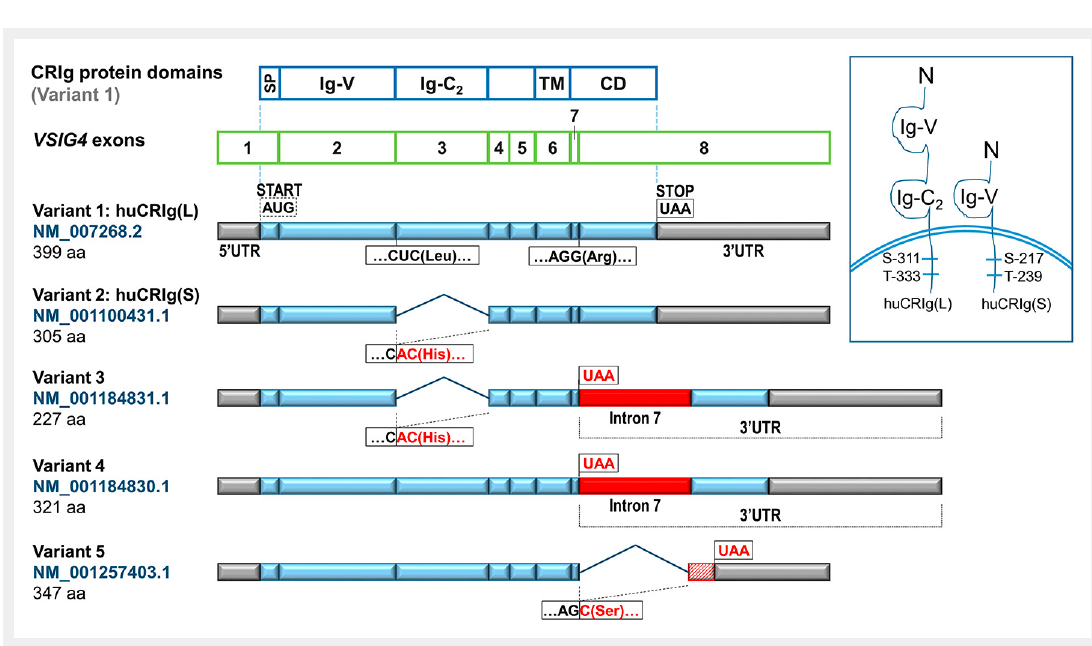
Schematic representation of the CRIg protein domains aligned with the five VSIG4 splice variant transcript structures. The transcripts structures are derived from the NCBI Reference Sequence Database (RefSeq) using the following mRNA accession numbers: NM_007268.2, NM_001100431.1, NM_001184831.1, NM_001184830.1, and NM_001257403.1, as noted in the figure. The structure of the longest CRIg isoform (variant 1, huCRIg(L)) is used as the reference, with the protein domains denoted as: SP, signal peptide; Ig-V, immunoglobulin domain V-type; Ig-C 2 , immunoglobulin domain V-type; TM, transmembrane region, and CD, cytoplasmic domain. The relative VSIG4 exon structure reveals that SP, Ig-V, Ig-C 2 , and TM are encoded specifically by exons 1, 2, 3, and 6, respectively, whereas CD is encoded by exons 7 and 8. The short form (variant 2, huCRIg(S)) differs from the long form by the exclusion of exon 3, the Ig-C 2 domain, and a change at codon 138 from CUC (Leucine) to CAC (Histidine). In this isoform, the overall size of the CRIg protein is reduced from 399 to 305 amino acids (aa). Variant 3 features this identical alteration, in addition to the inclusion of intron 7 which creates a stop codon (UAA) adjacent the last codon of exon 7, causing the majority of the CD to be missing (227 aa). Variant 4 features the same loss of the CD as variant 3, but retains all other domains (321 aa). Variant 5 retains the same domains as variants 1 and 4 (exon 1 to 7 inclusive), but is unique from the other four variants in that a portion of exon 8 is excluded, which creates a change at codon 321 (exon 7-8 junction) from AGG (Arginine) to AGC (Serine), followed by a ‘frameshift’ that results in a stop codon generated 26 aa downstream (347 aa). Insert: shows a schematic representation of the long and short forms of CRIg, expressed in macrophages. The extracellular portion of CRIg contains an Ig-V and/or Ig-C 2 domain(s). Putative phosphorylation sites for cAMP/cGMP-dependent protein kinase (S-311 or S-217) and protein kinase C (T-333 or T-239) have been proposed to be present in the cytoplasmic domain of